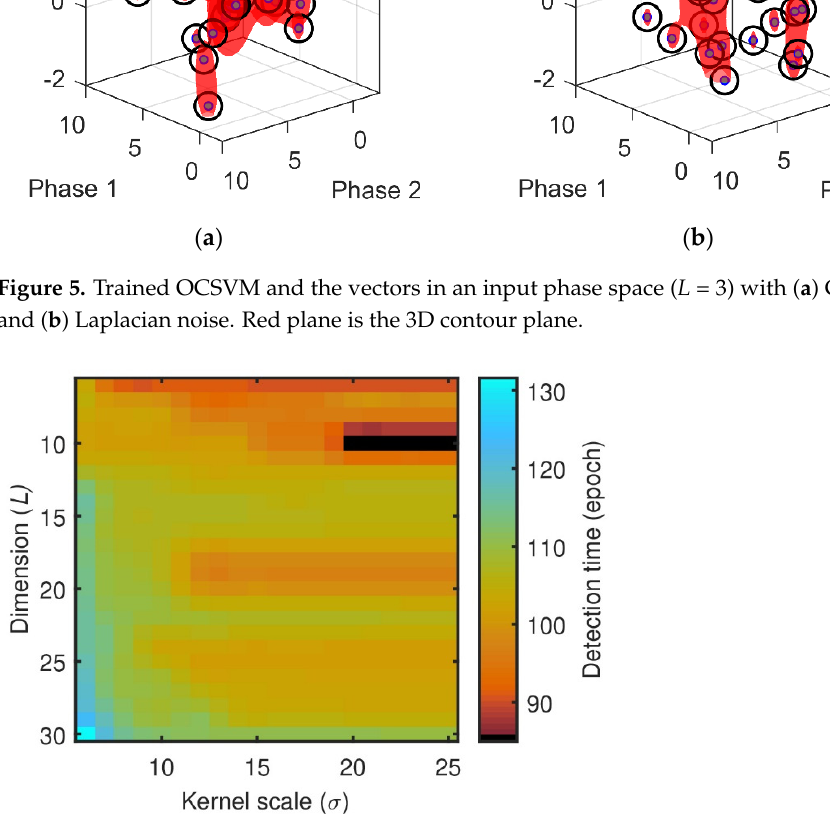
Figure 6. Variation of the average detection time in relation to L and σ with synthetic data. The minimum time of 86 epochs occurs when σ = 20 and L = 10.